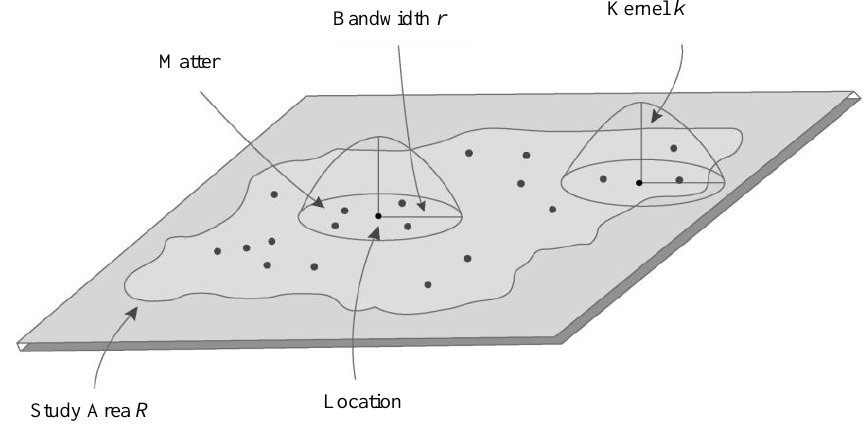
Figure 1. The model of kernel density estimation. Figure 2 exhibits the algorithm flow of hotspot detection according to density field.